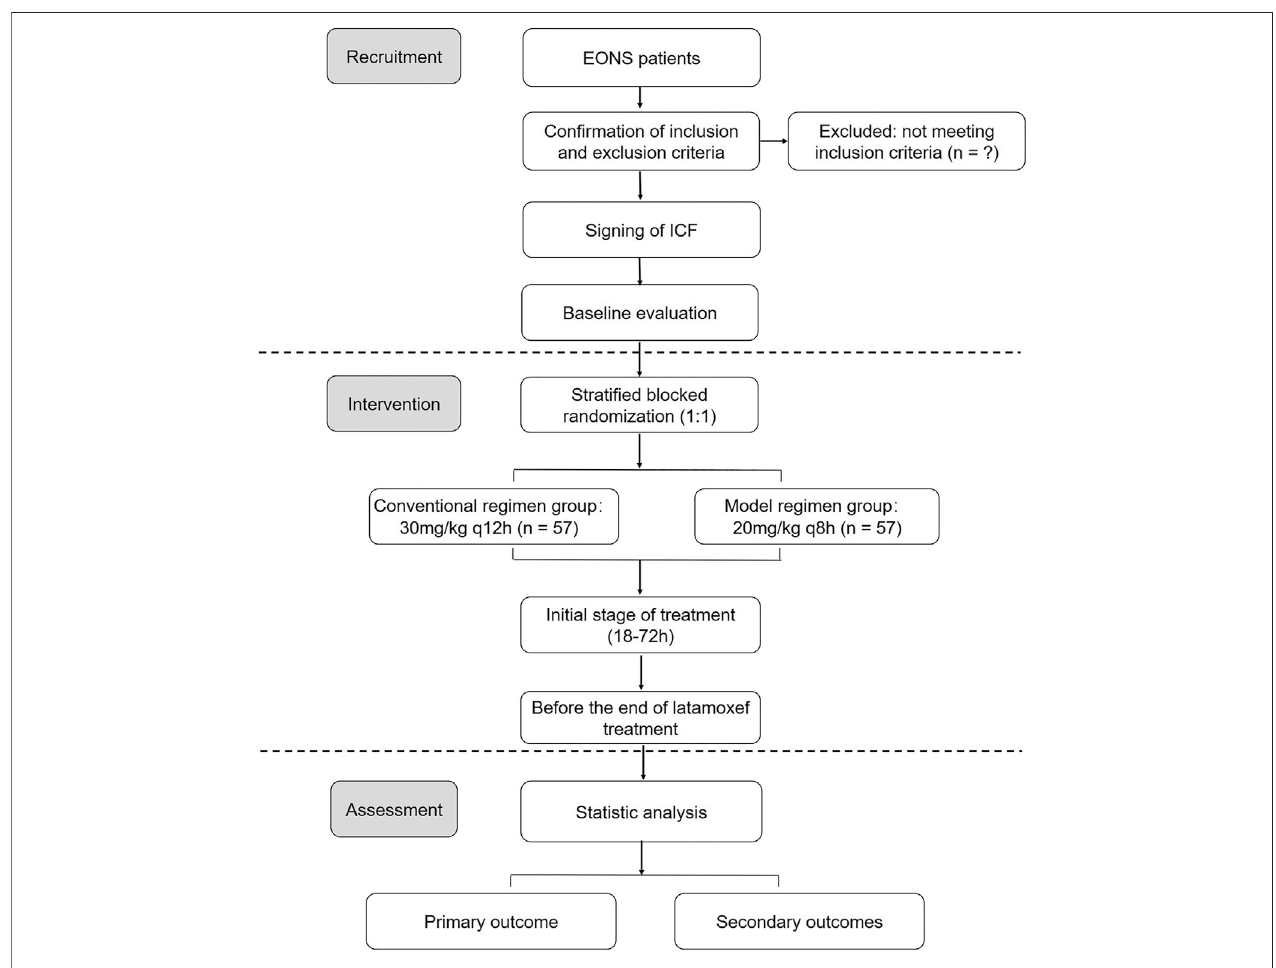
FIGURE 1 | The schematic diagram of the trial design.